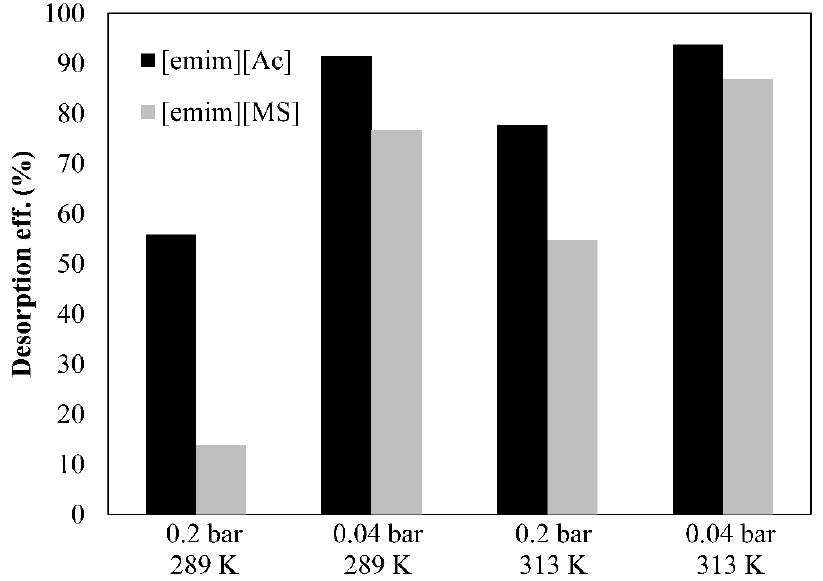
Figure 6. Desorption efficiency by using 2 ILs at different vacuum pressures and temperatures. Commercial HFMC operational conditions: liquid flow rate 60 mL · min − 1 .